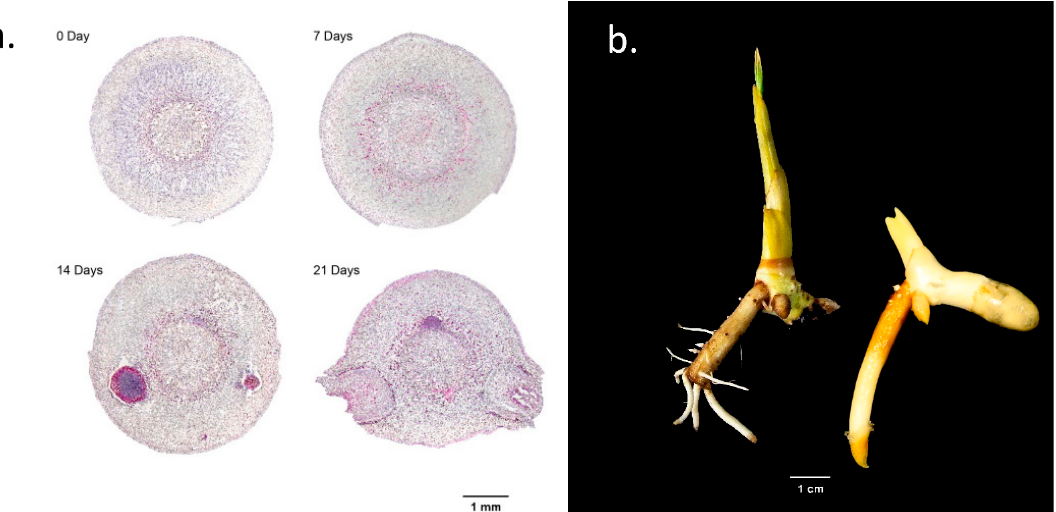
Figure 5. Lateral root development after excision was visible at 2 weeks after root excision. ( a ) Trans- verse section of the root showing lateral root formation on day 0, day 7, day 14, and day 21 after primary root excision. ( b ) A month-old makapuno seedling with lateral root growth around the excised area at the primary root that also showed induced shoot growth (left) compared to a makapuno seedling of the same age with an intact primary root that had no lateral root and much less shoot growth.